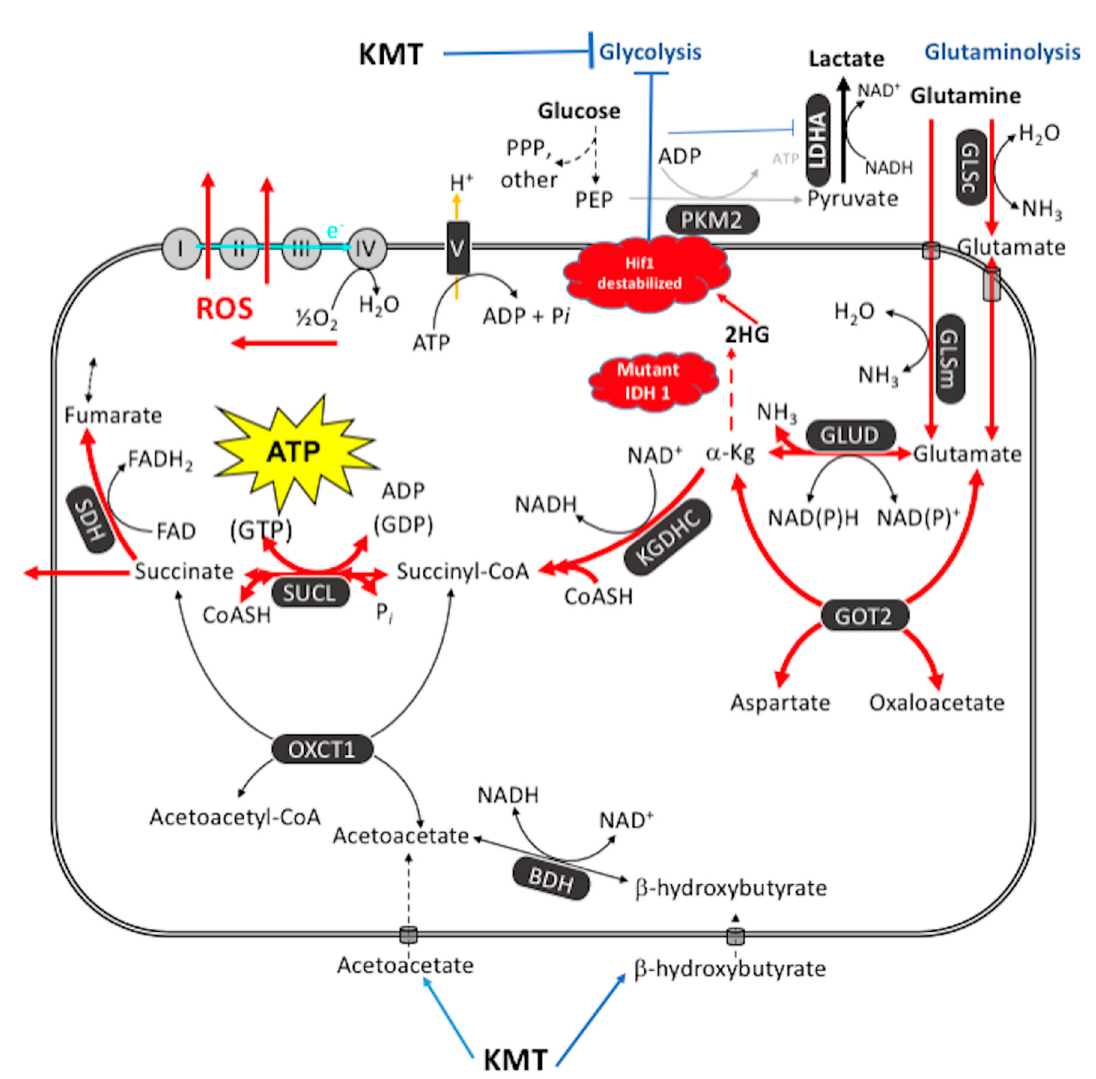
Figure 4. Glutamine-driven mSLP as a major source of ATP synthesis in cancer cells and inhibition by the therapeutic IDH1(R132H) mutation. ATP synthesis through mSLP at the succinate-CoA ligase reaction (SUCL) in the glutaminolysis pathway (red) can compensate for inefficient ATP synthesis through OxPhos in tumor cells with mitochondrial abnormal- ities [83]. mSLP can also compensate for inefficient ATP synthesis through glycolysis in cancer cells that express the cytoplasmic PKM2 isoform, which produces less ATP than the PKM1 isoform [84]. These bioenergetic compensations will hold the ∆ G’ ATP hydrolysis at − 56 kJ/mole, thus maintaining cancer cell viability in either the presence or the absence or oxygen. Oxygen consumption in cancer cells is used more for production of ROS, which are carcinogenic and mutagenic, than for ATP synthesis. Moreover, mSLP will maintain the forward operation of the adenine nucleotide translocase thus preventing depletion of cytosolic ATP reserves from the reverse operation of the F0-F1 ATP synthase [84,182]. Release of succinate to the cytoplasm can help stabilize Hif-1 α , thus linking lactic acid fermentation through glycolysis to glutamine fermentation through glutaminolysis. Ketogenic metabolic therapy (KMT) will reduce availability of glucose to the gly- colytic and the PPP pathways while diverting CoA from succinate to acetoacetate under the metabolism of ketone bodies ( β -hydroxybutyrate and acetoacetate) thus indirectly reducing ATP synthesis through the SUCL reaction. The therapeutic IDH1 mutation will further reduce ATP synthesis through mSLP by increasing synthesis of 2-hydroxyglutarate (2HG) from α -ketoglutarate and thus reduce the succinyl CoA substrate for the SUCL reaction [83,215]. Besides its potential effect